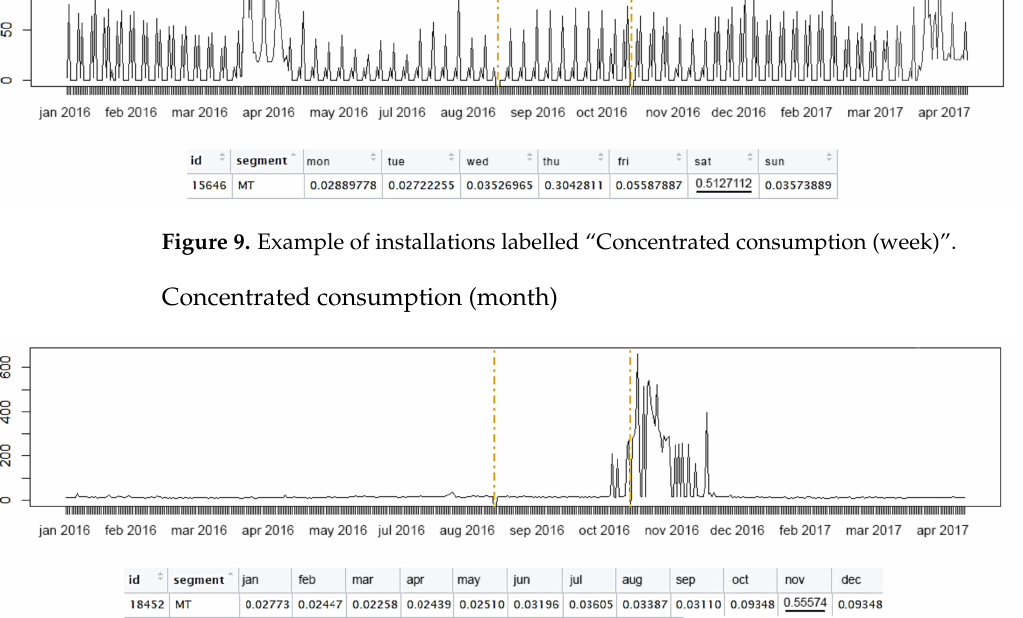
Figure 10. Example of installations labelled “Concentrated consumption